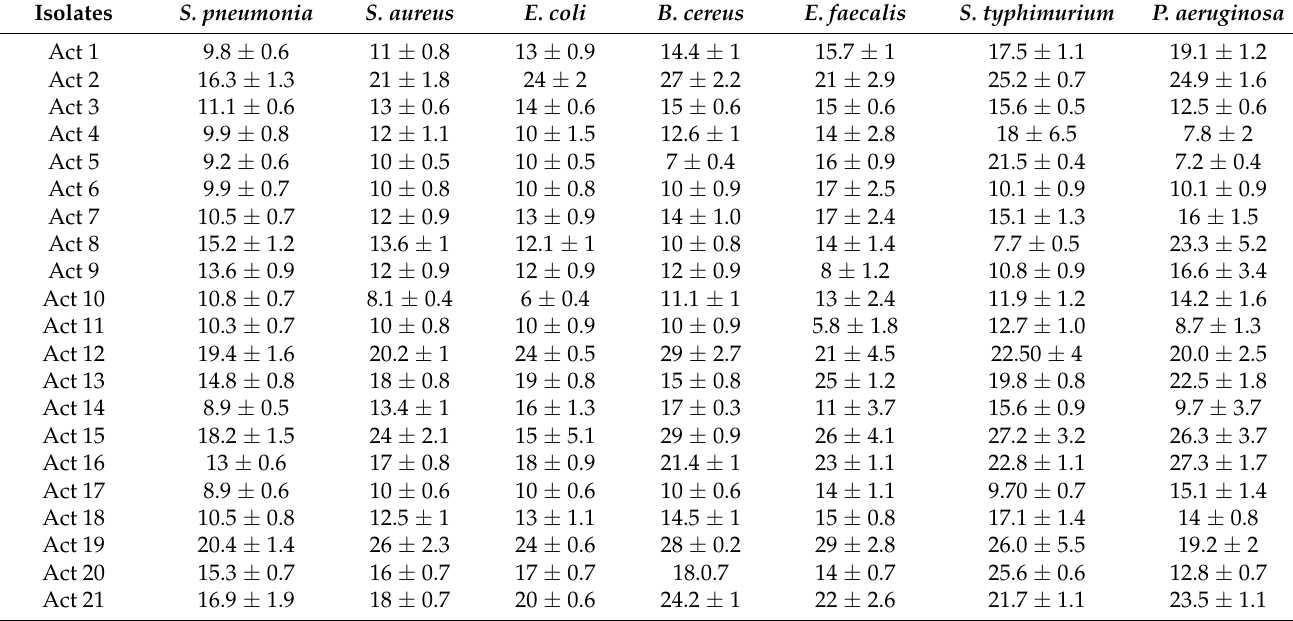
Table 3. Screening for antibacterial activities of actinobacterial isolate cell-free extracts. Data are represented by the means of at least 3 replicates ± standard deviations (SD).